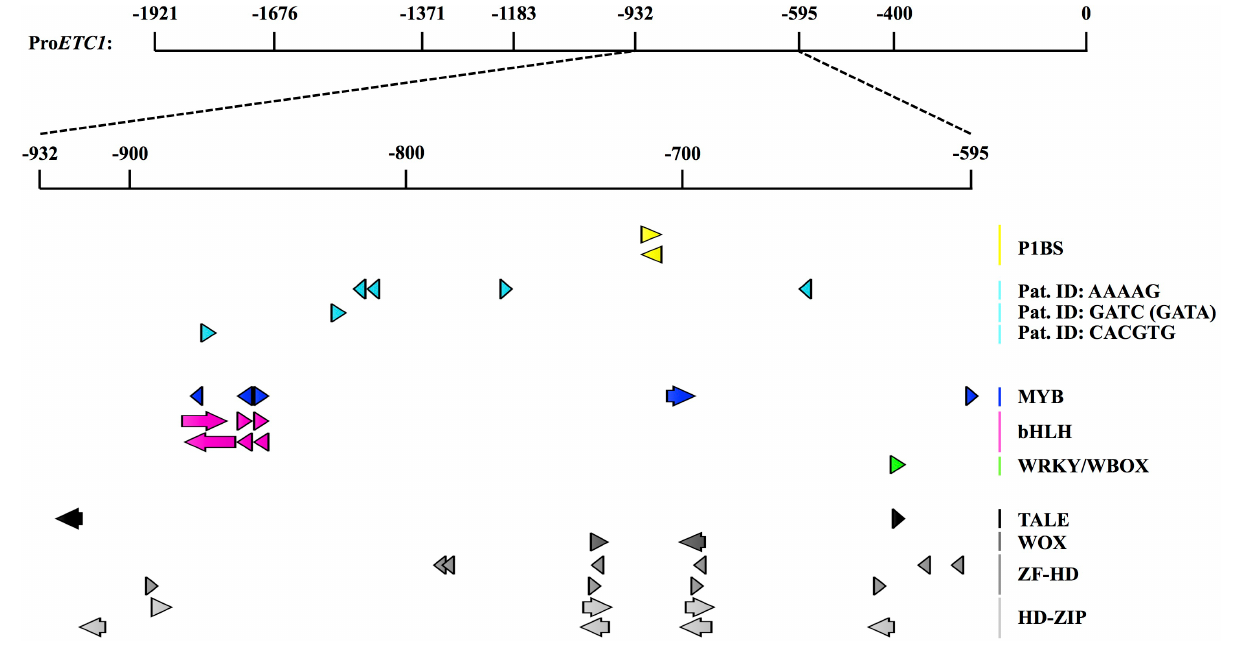
FIGURE 4 | Cis -regulatory elements and motifs related to Pi responsiveness and patterning with the selected ProETC1 fragment. Detailed analysis of cis -regulatory motives in the Pro ETC1 − 932 - − 595 fragment using PlantPAN 2.0 (Chow et al., 2016) and manual analysis with motifs from a recent publication (Salazar-Henao et al., 2016). The figure was constructed using the CLC DNA Workbench (see text footnote 4). P1BS was previously identified by PLACE (Higo et al., 1999) mutated in this study and did not show to be causative. Recently, 14 root specific Pi-responsive motifs were identified (Salazar-Henao et al., 2016). Three of these were found in the selected Pro ETC1 fragment (labeled “Pat. ID”). Below, patterning related motifs extracted from a PlantPAN 2.0 analysis are shown. Orientation of motifs: +: arrows point to the right, – strand: arrow points to the left. P1BS, PHR1-binding site; Pat. ID, pattern identifier from Salazar-Henao et al. (2016); TALE, three amino acid